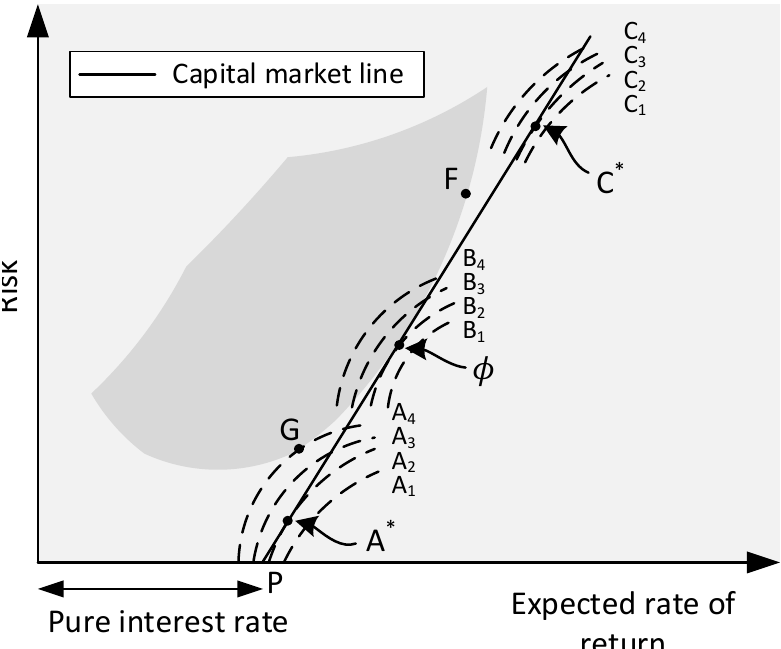
Figure 1. Capital market line by William Sharpe